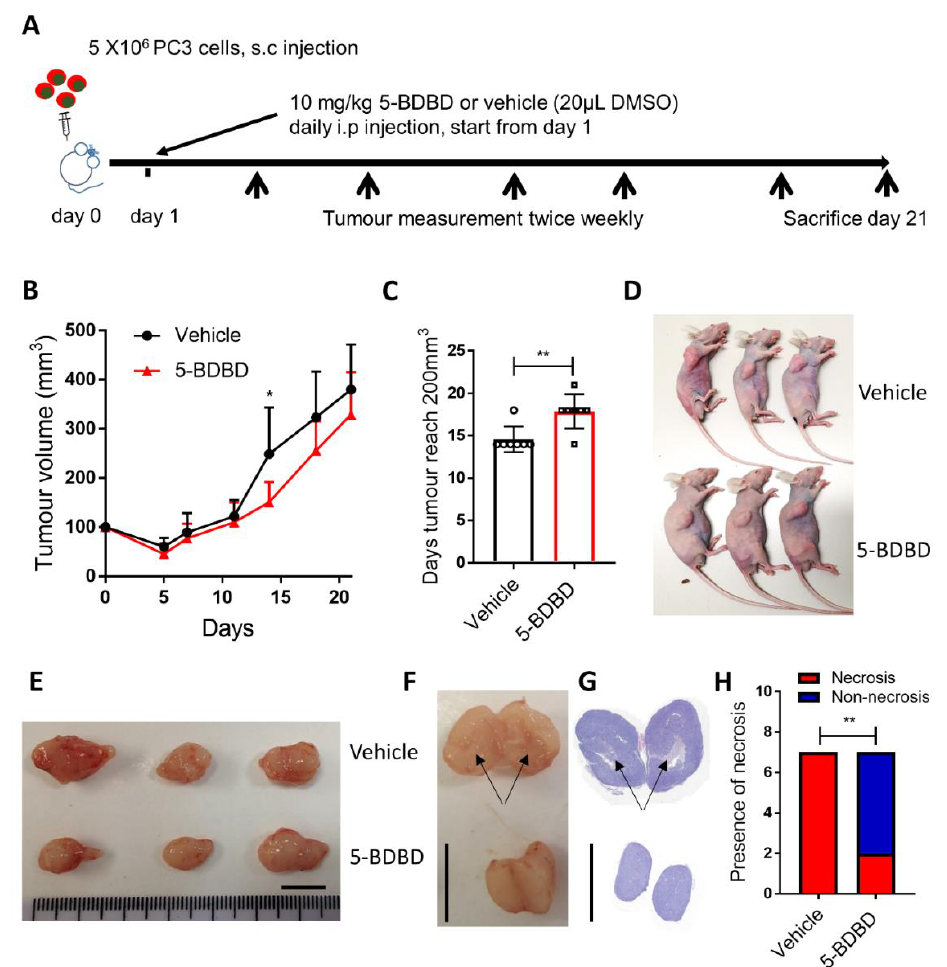
Figure 4. P2X4R antagonist 5-BDBD delays the PCa growth in vivo. ( A ) Schematic outline of the in vivo study. Briefly, six-week old BALB/cAnNCrl immunocompromised mice were subcutaneously (s.c) injected with 5 × 10 6 PC3 cell suspension with 50% PBS + 50% Matrigel. After randomization, the mice were daily intraperitoneally (i.p) injected with the P2X4R antagonist 5-BDBD at a dosage of 10 mg/kg or vehicle (20 μL DMSO), starting from day one until being euthanized three weeks post-tumour cell inoculation. ( B ) Tumour sizes were measured by using vernier calipers twice a week, and then tumour volumes were calculated as ellipsoids and compared between treated and vehicle groups. ( C ) Days needed for tumours to reach 200 mm 3 were also compared between treated and vehicle groups. Data are the mean ± SD, n = 7, Student’s t-test, * p < 0.05, ** p < 0.01. Representative images of ( D ) tumour-bearing mice and ( E ) dissected tumours, comparing treated and vehicle groups at endpoint. ( F ) Dissected tumours were then cut in half and revealed a necrotic centre in the tumour from the vehicle control group but not the treated group. ( G ) This was further confirmed by H&E staining of the tumours. Scale bar = 1 cm. ( H ) A statistical analysis with a Chi-square test suggested a significantly reduced presence of necrosis in the 5-BDBD-treated group compared to the vehicle. n = 7, ** p < 0.01.